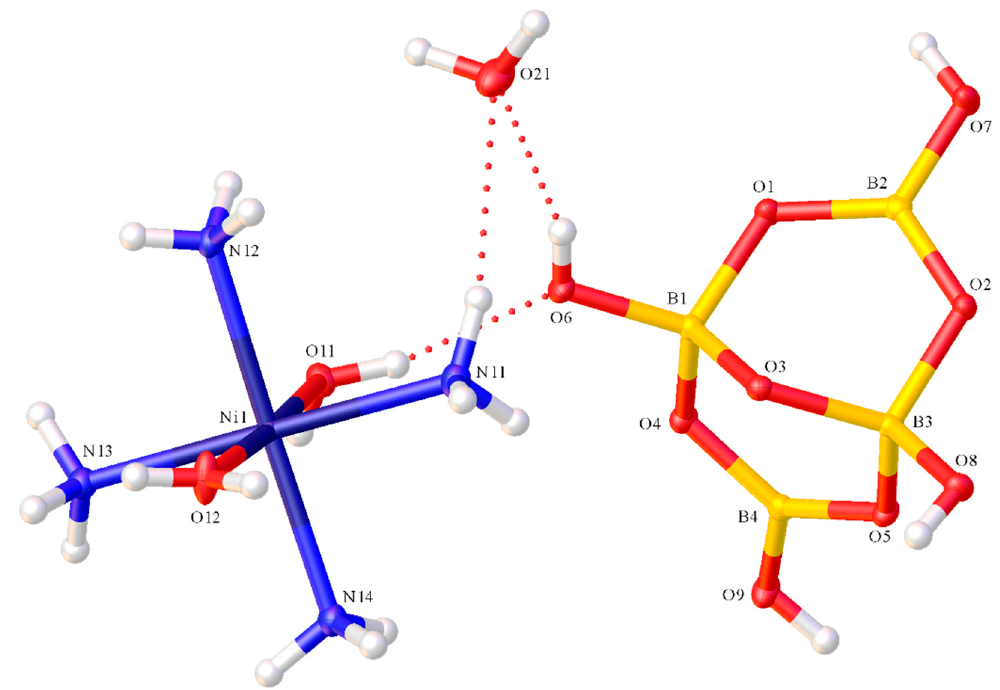
Figure 5. Drawing of structure of trans -[Ni(NH 3 ) 4 (H 2 O) 2 ][B 4 O 5 (OH) 4 ] . H 2 O [Ni(dmen)(H 2 O){B 6 O 7 (OH) 6 }] . 5H 2 O ( 1 ), showing (selected) crystallographic numbering and the R 33 (8) ring system: {Ni1-O11A-H11A … O6-H6 … O21 … H11E-N11}.